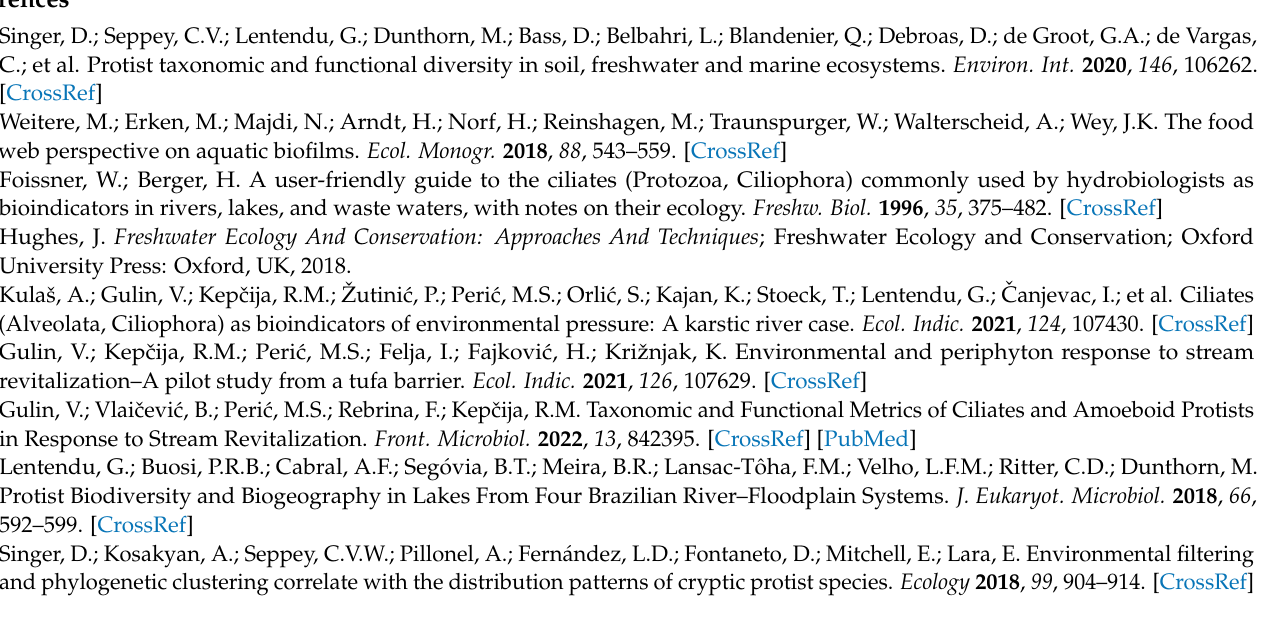
habitats. Supplementary Table S4. Results of non-metric multidimensional distance scaling (NMDS) analysis of the Unifrac distance indices of the ciliate community at OTU level with environmental parameters (DIC = dissolved inorganic carbon, DOC = dissolved organic carbon, EC = conductivity, N-NO 3 − = nitrates, O 2 = oxygen saturation, pH, P-PO 43 − = phosphates, T = temperature, TN = total nitrogen). Statistically significant results ( p < 0.05) are reported in